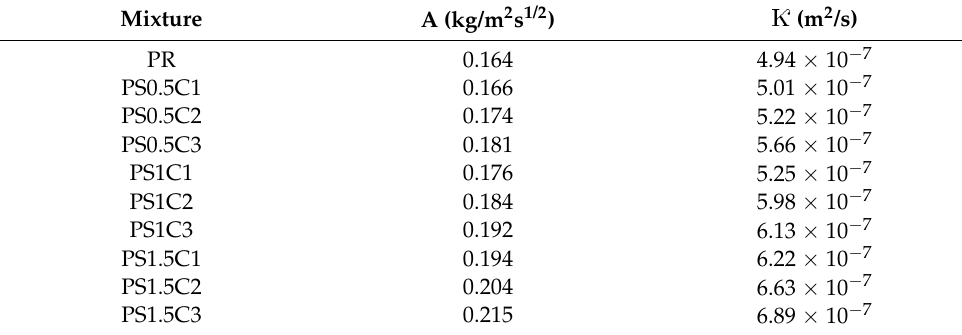
Table 3. Hygric properties of studied plasters.